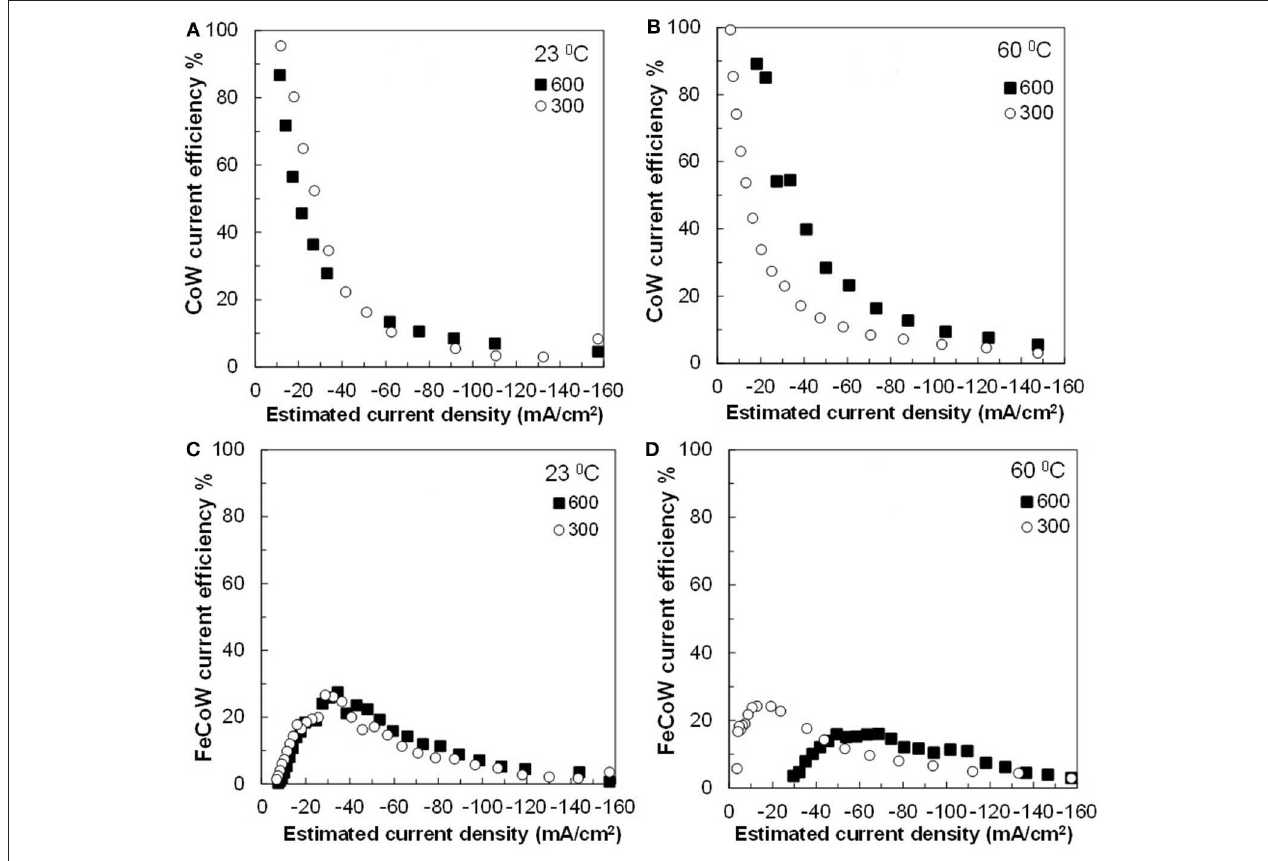
FIGURE 5 | Current efficiency for (A,B) Co–W and (C,D) Fe–Co–W deposits at two temperatures 23 and 60 ◦ C, and at an electrode rotation rates of 300 and 600